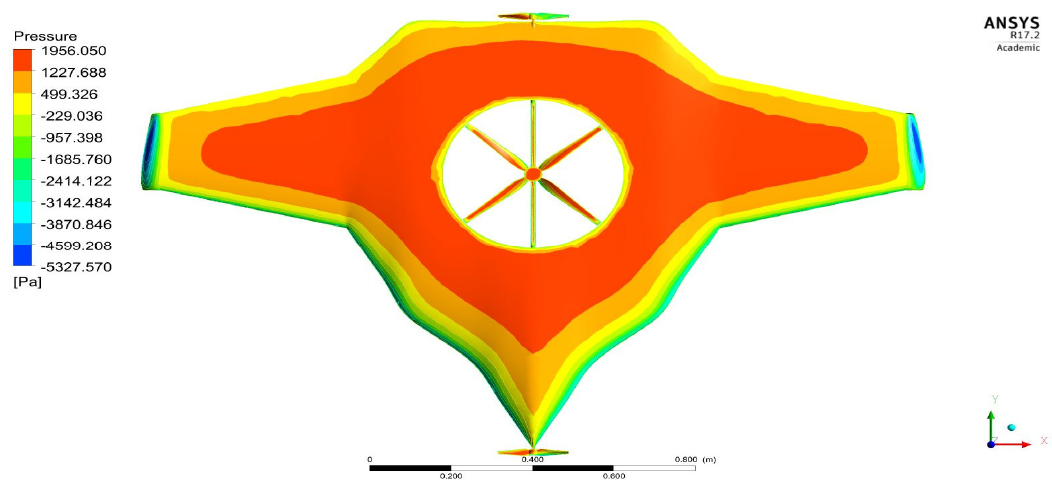
Figure 9. Pressure variations on UAV under VTOL.